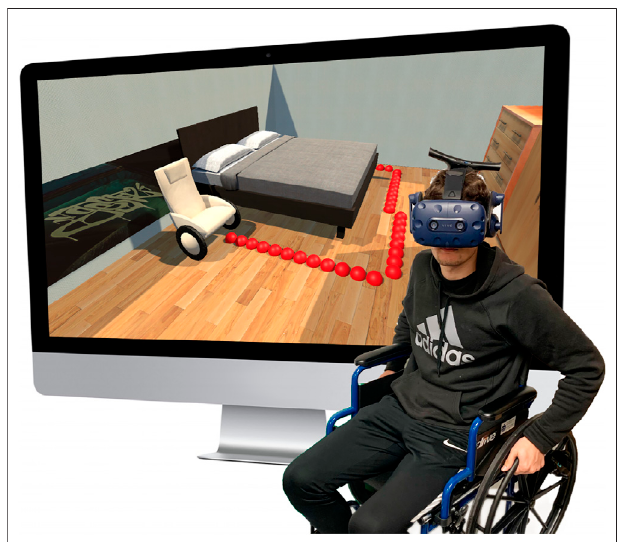
FIGURE 8 | A user performs a wheelchair training in VR. Courtesy of Li et al.